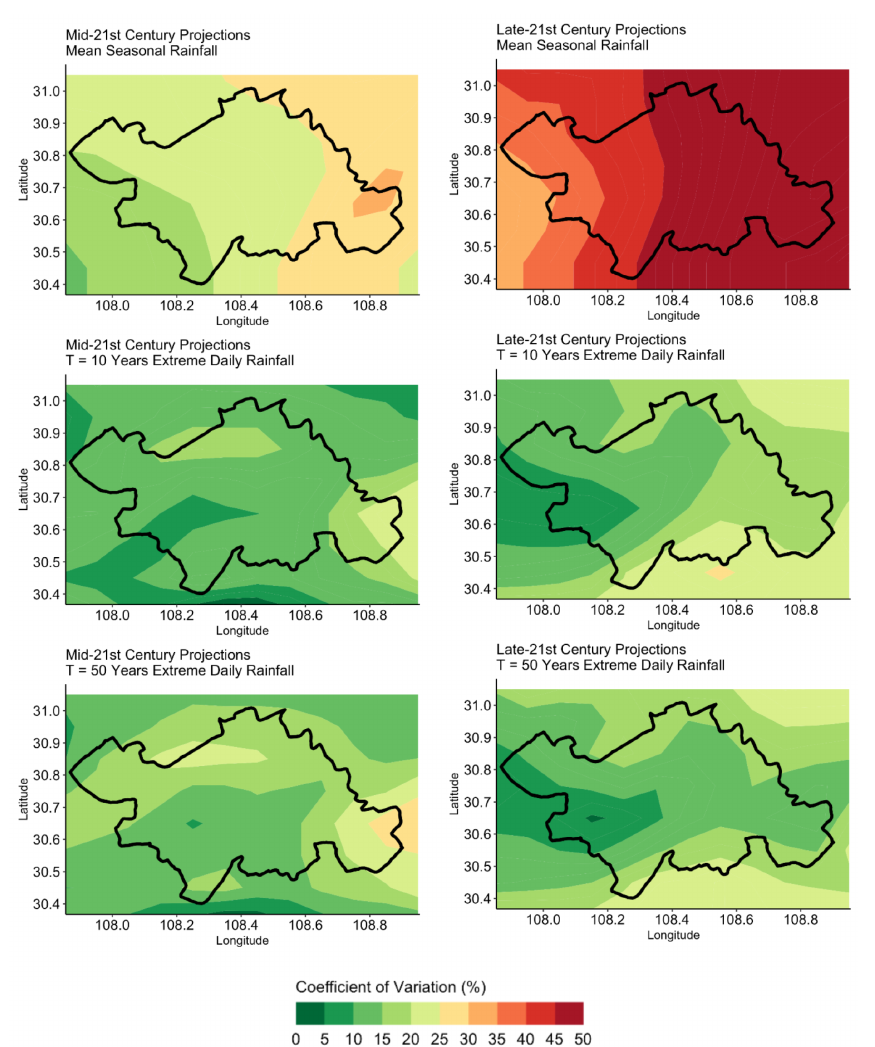
Figure 11. Coefficients of variation of the ensemble projections of climate change factors for mean seasonal rainfall and extreme daily rainfall in the late-21st and mid-21st century scenarios.